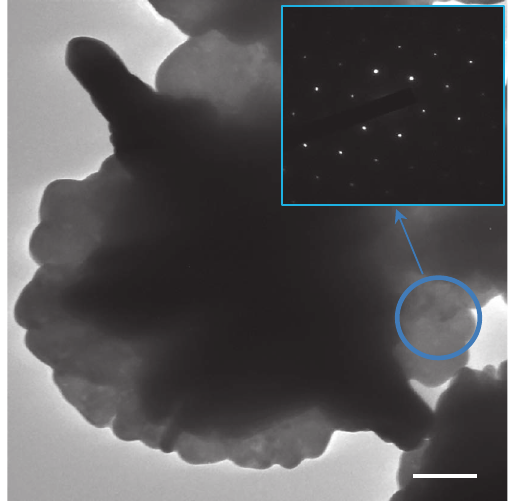
Fig. 6 A TEM image of the silver flower and the selected area electron diffraction pattern (inset) from the flower. The scale bar represents 200